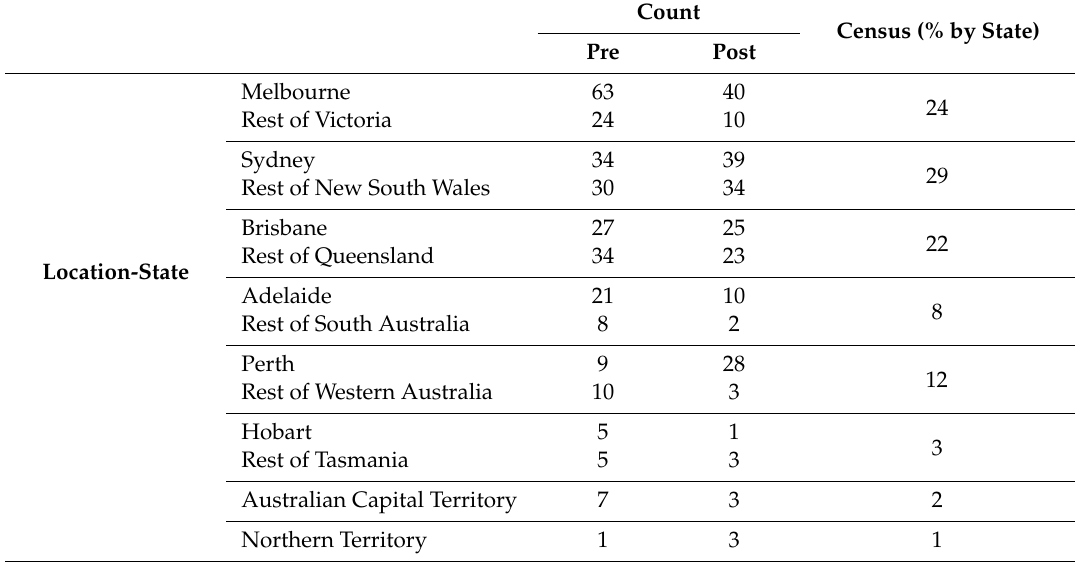
Table 3. Geographic location of participants in the CATI survey pre and post the 60 Minutes programme. Count Census (% by State) Pre Post Melbourne 63 40 24 Rest of Victoria 24